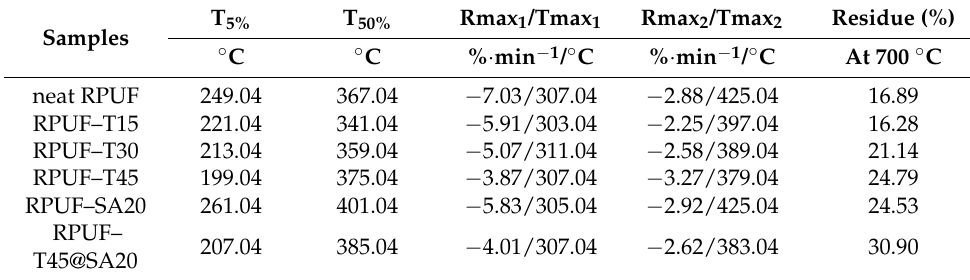
Figure 7. TGA curves of RPUFs under N 2 ( a ) and under air ( b ), DTG curves of RPUFs under N 2 ( c ) and under air ( d ). Table 3. TGA and DTG data of RPUFs under N 2